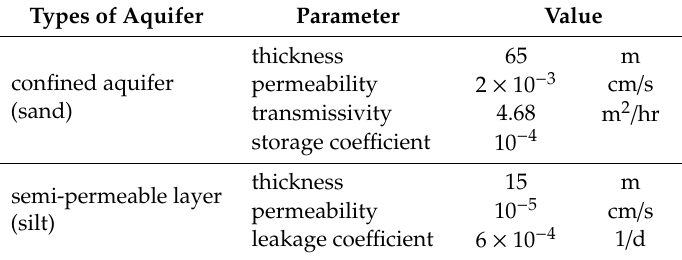
Figure 17. Schematic of numerical example 5. Table 3. Parameters used in the numerical example